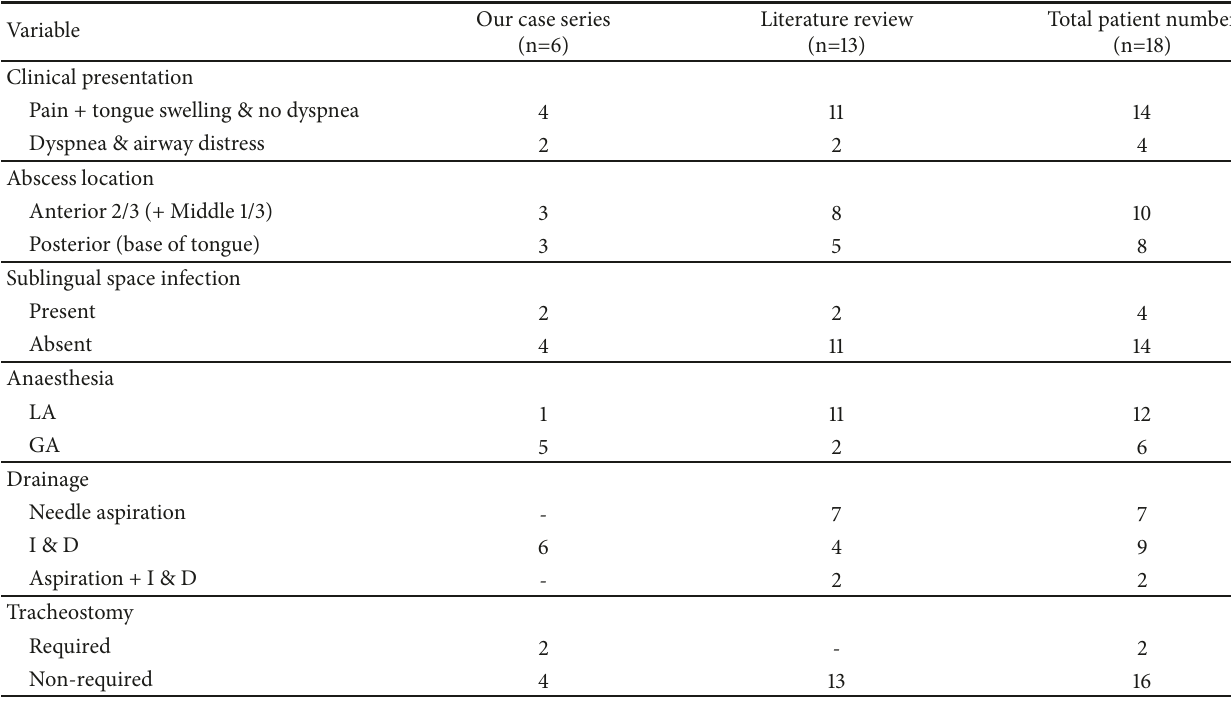
Table 4: Clinical manifestation, location of abscess, and management of our case series and case series from literature review.